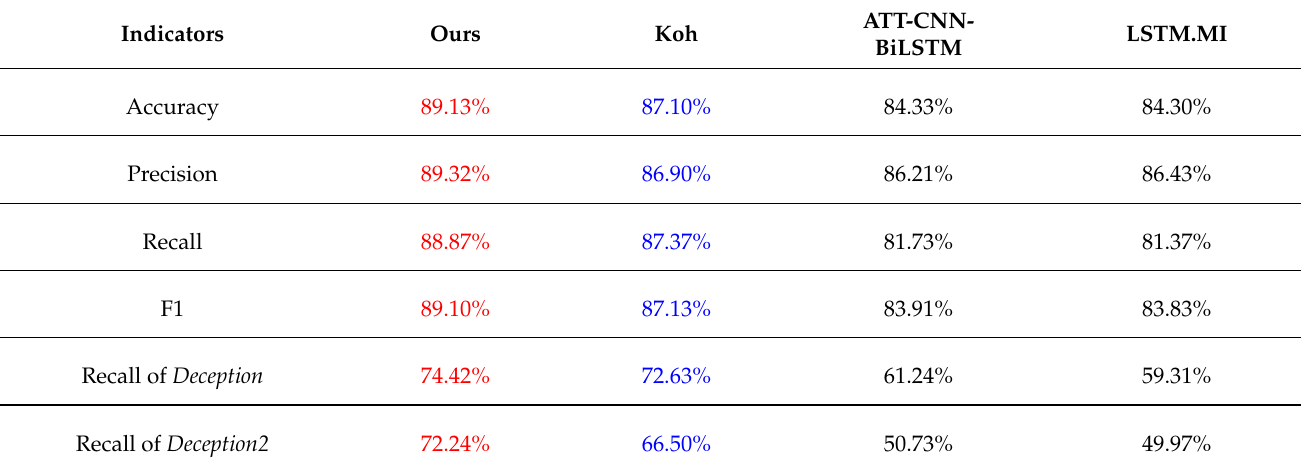
Table 6. Comparison of adversarial DGA